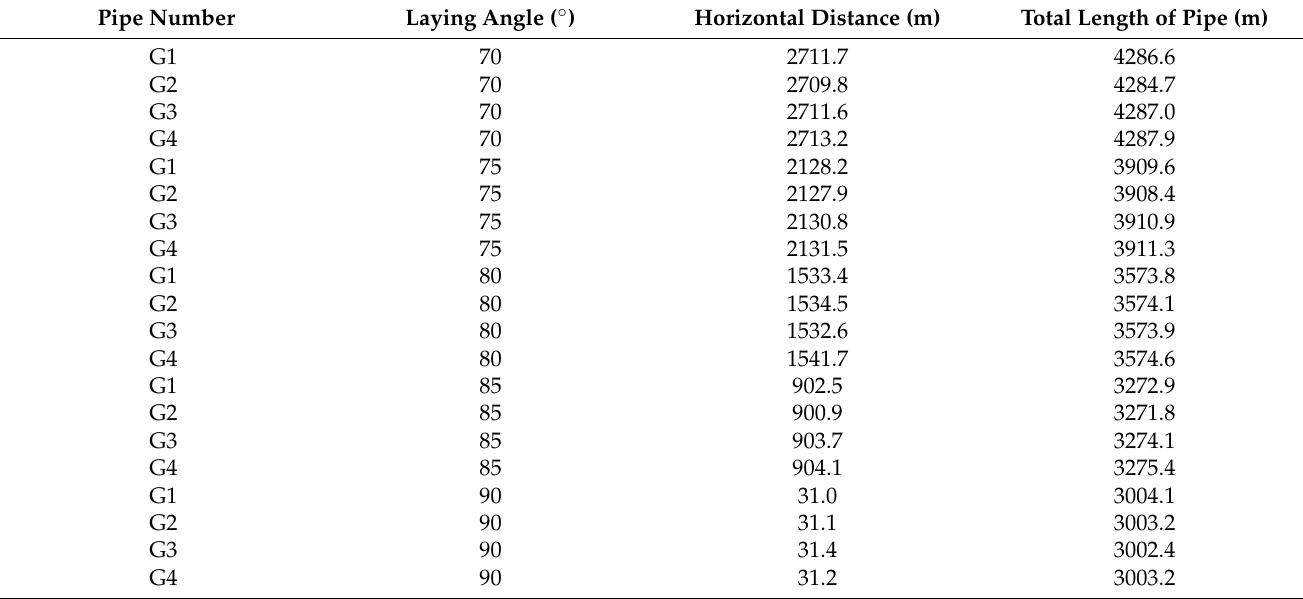
Table A2. Line type of pipeline laying for all sizes under 3000 m laying depth.